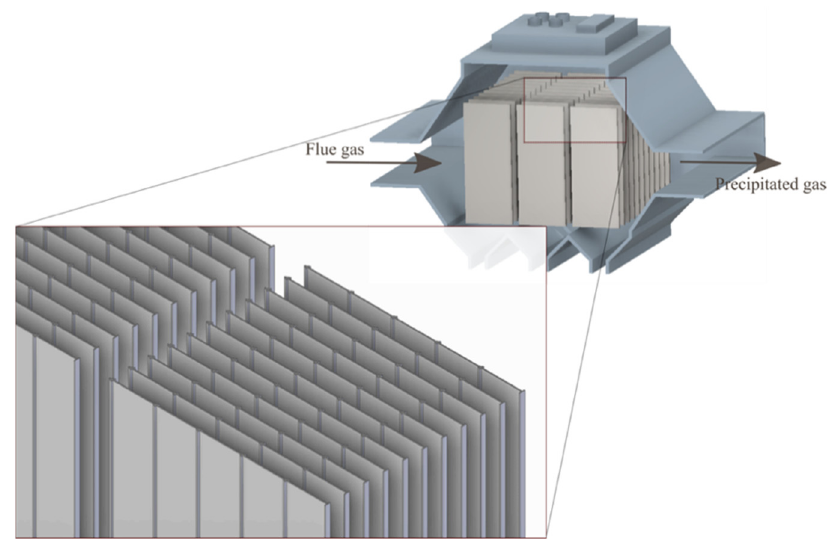
Figure 8. Opzel-type collecting plate layout of a single-stage ESP in a cross-sectional view.